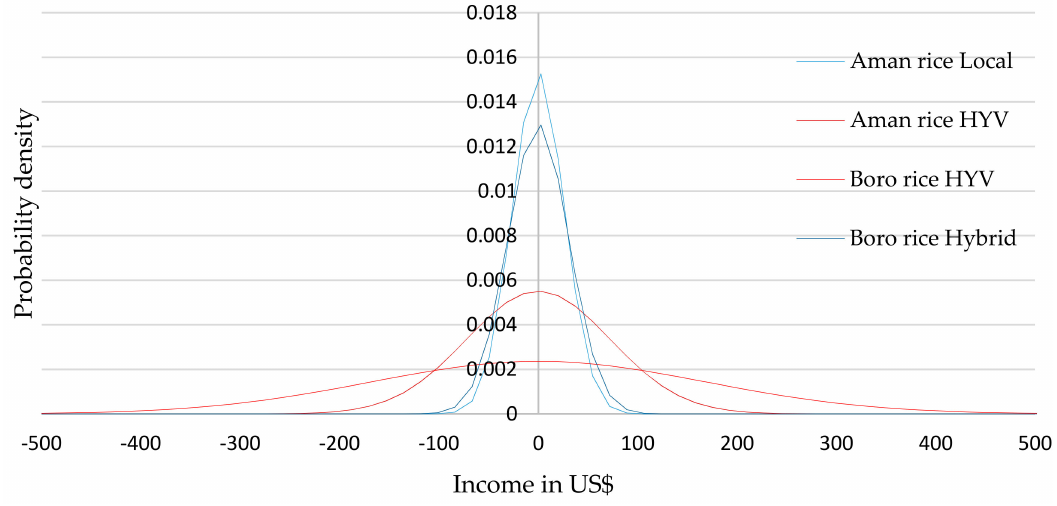
Figure 8. Distribution of agricultural income for farm households in Mymensingh by crop